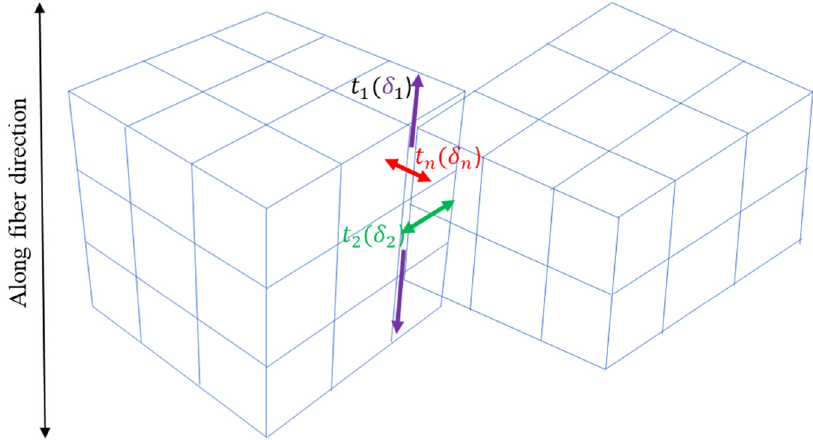
Figure 11: Traction separation